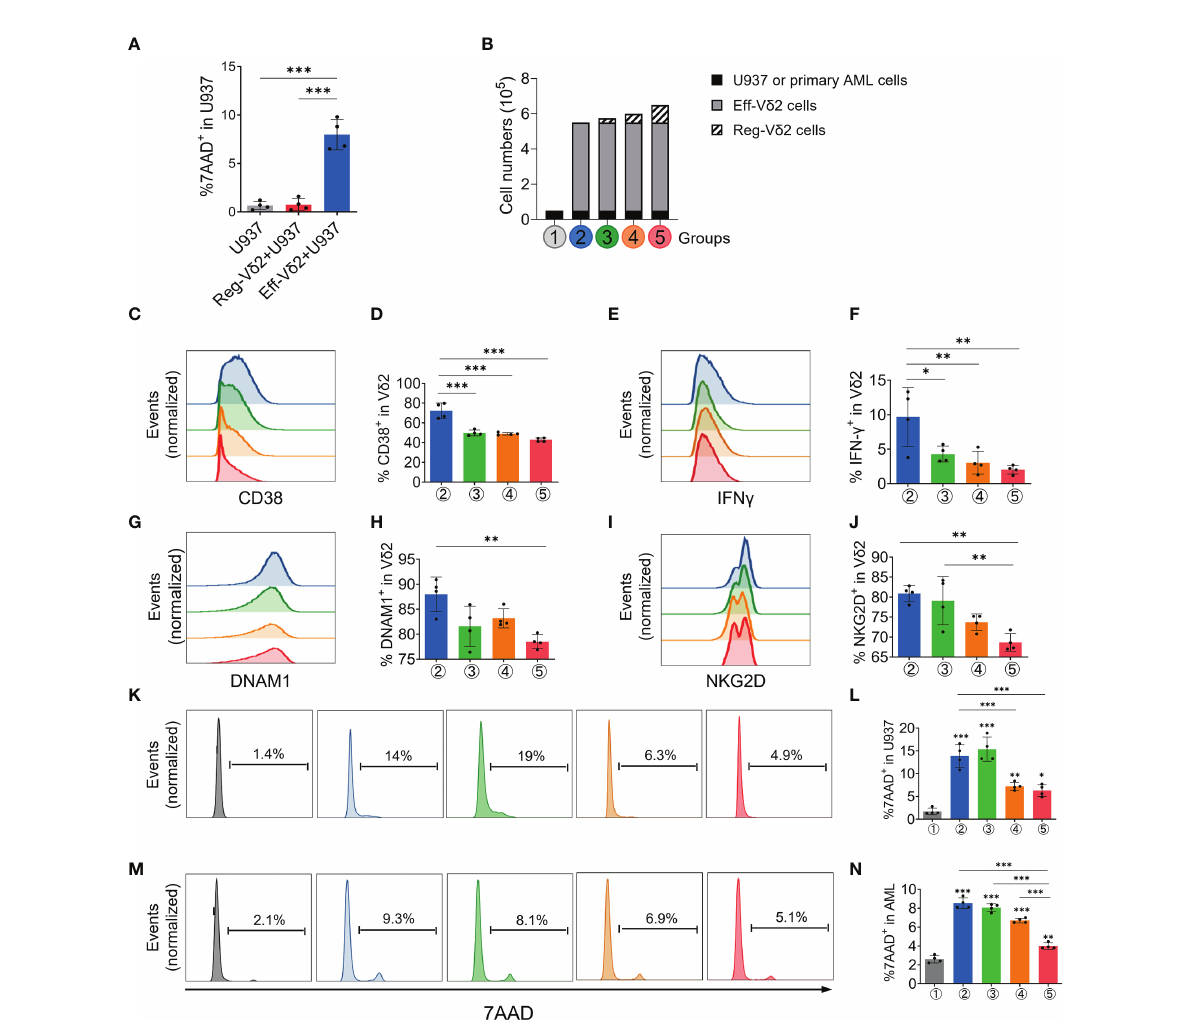
FIGURE 4 Impact of Reg-V d 2 cells on the cytotoxicity of effector V d 2 cells against AML in vitro . (A) Comparison of 7-AAD positive fractions in U937 cells after co-culture with Reg-V d 2 and Eff-V d 2 cells respectively. n = 4, *** P < 0.001. (B) Experimental groups showing that human AML cells (U937 cell line or primary leukemia cells isolated from patients with AML-M2, Group ① ) were co-cultured with Eff-V d 2 cells (Group ② ), and with additional Reg-V d 2 cells at ratios of 20:1 (Group ③ ), 10:1 (Group ④ ), and 5:1 (Group ⑤ ) respectively. Representative fl ow cytometry histograms and the statistical analyses for expressions of CD38 (C, D) , IFN- g (E, F) , DNAM1 (G, H) , and NKG2D (I, J) in V d 2 cells among the indicated groups. (K, L) Representative histograms of fl ow cytometry and the statistical analyses for 7-AAD positive fractions in U937 cells among the indicated groups. (M, N) Representative histograms of fl ow cytometry and the statistical analyses for 7-AAD positive fractions in primary AML cells among the indicated groups. Statistical differences were analyzed using the one-way analysis of variance (ANOVA). n = 4, * P < 0.05, ** P < 0.01, *** P <